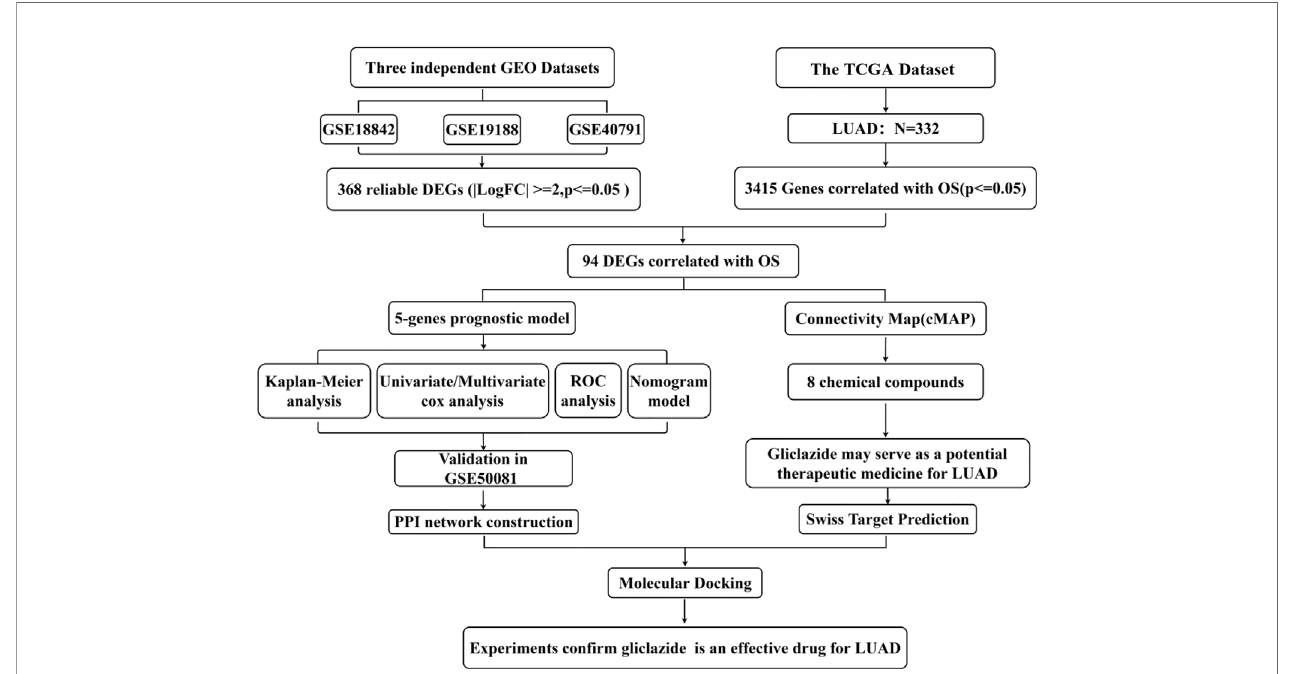
FIGURE 1 | Study fl ow diagram. OS, overall survival; DEGs, differentially expressed